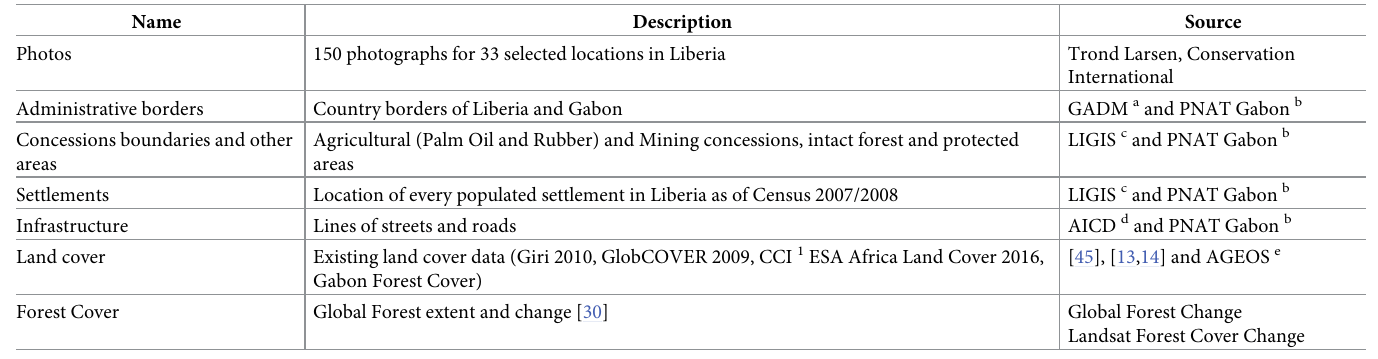
Table 1. List of ancillary